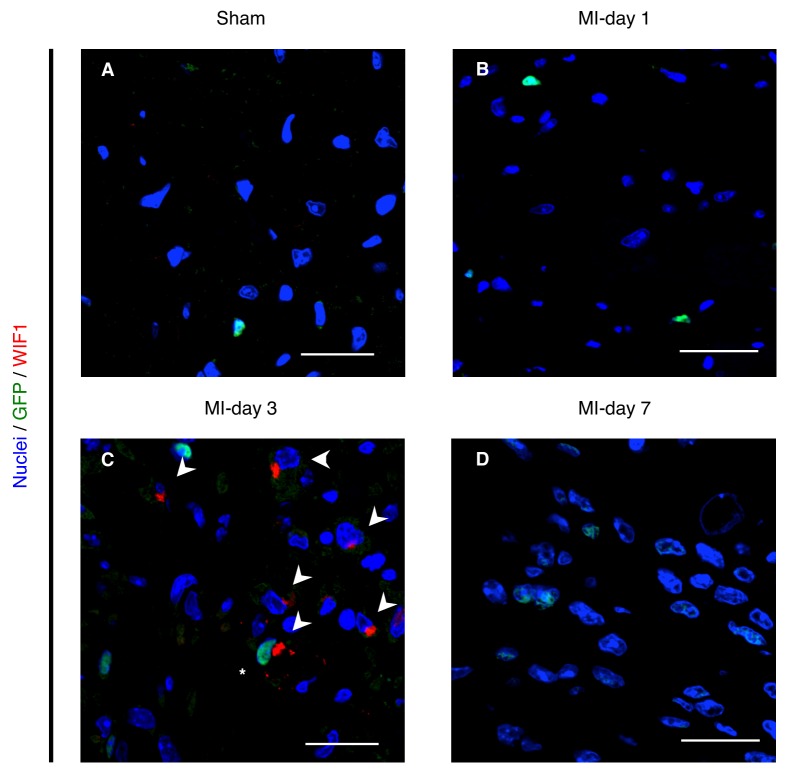
WIF1 protein expression after sham or MI.(A–D) Representative images of WIF1 (red) and GFP (green) co-immunostainings in the left ventricle (sham, A) or in the infarcted border zone of hearts, 1 (B), 3 (C) or 7 (D) days after surgery. Arrowheads show WIF1+ cells, Asterix shows WIF1+GFP+ cell. Scale bar - 20 μm.